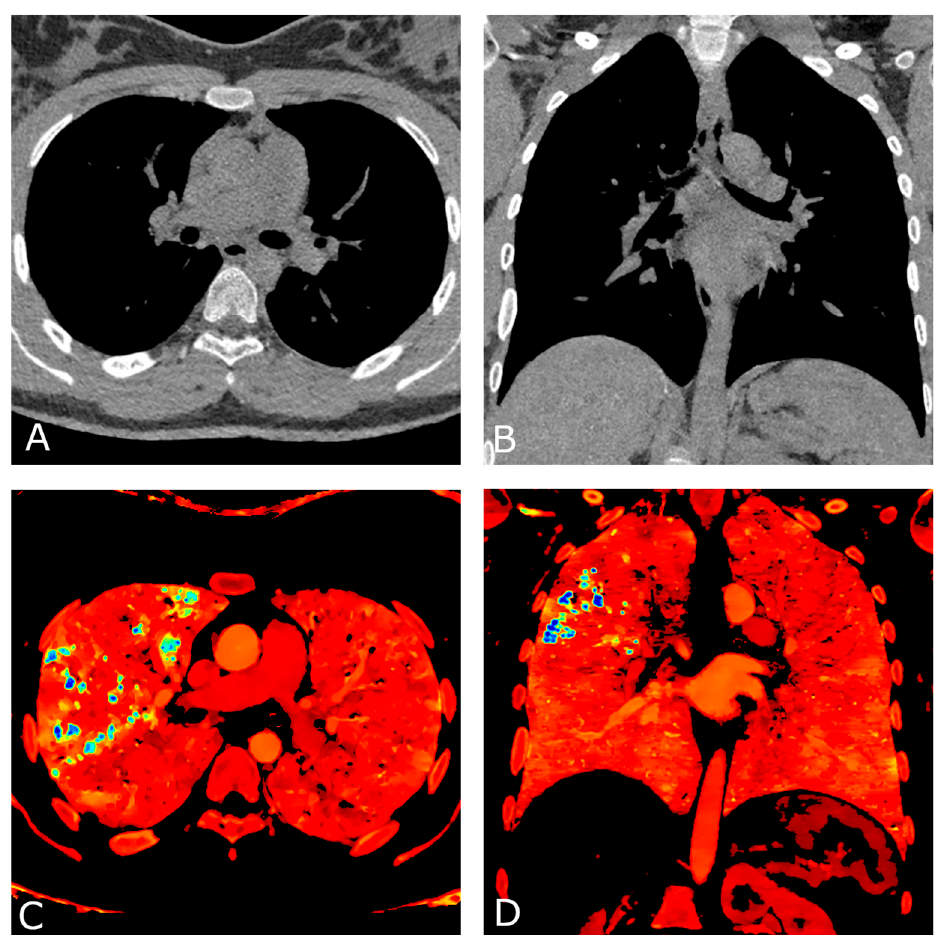
Figure 2. Chest CT angiography with ECG gating performed on a dual-layer DECT platform. Axial ( A ) and coronal ( B ) virtual non-contrast reconstruction (VNC) images. All pulmonary lesions are removed along with the iodinated contrast medium, suggesting similar Z number of their composition material with the iodinated contrast agent. Axial ( C ) and coronal ( D ) color-coded reconstruction maps based on Z-effective number, depict higher values of the pulmonary nodules (blue) compared to iodinated structures (green), consistent with a higher Z number of barium (Z = 56) than iodine (Z =